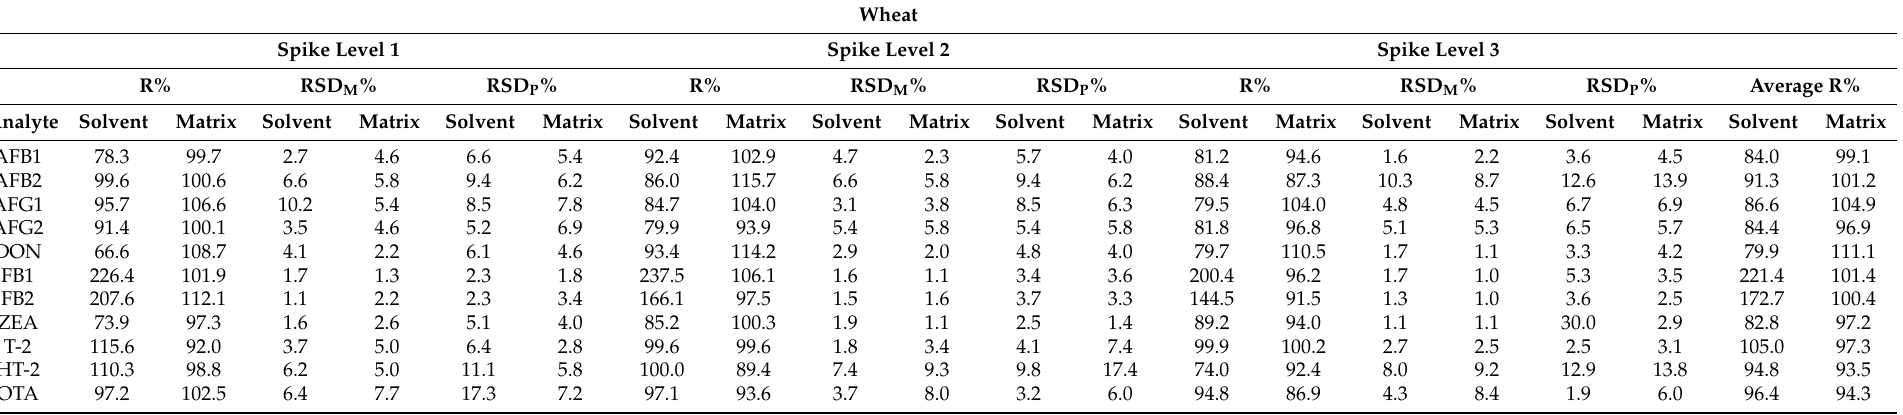
Table 8. Method recovery (R%) and repeatability of measurement (RSD M %) and sample preparation (RSD P %) in wheat using solvent and matrix-matched